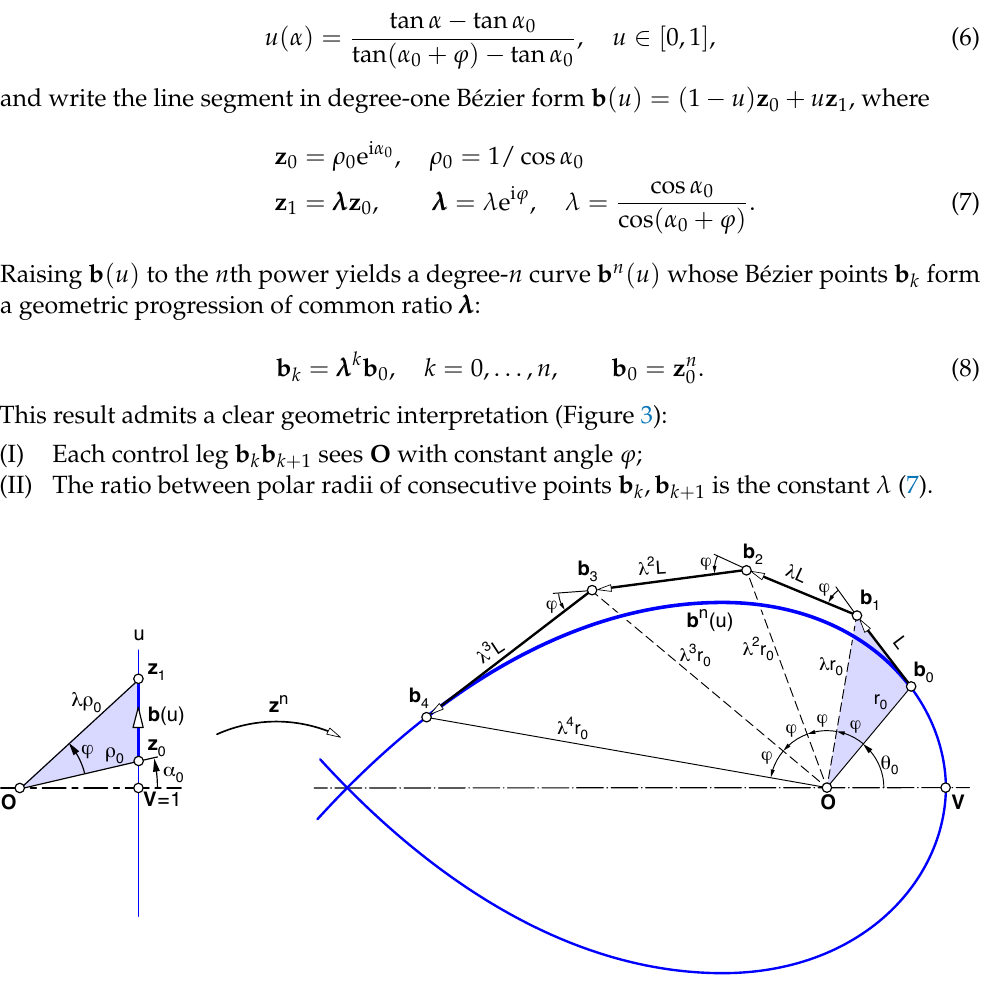
Figure 3. Raising to the n th power a line segment b ( u ) generates a degree- n typical curve b n ( u ) , ( n = 4 )